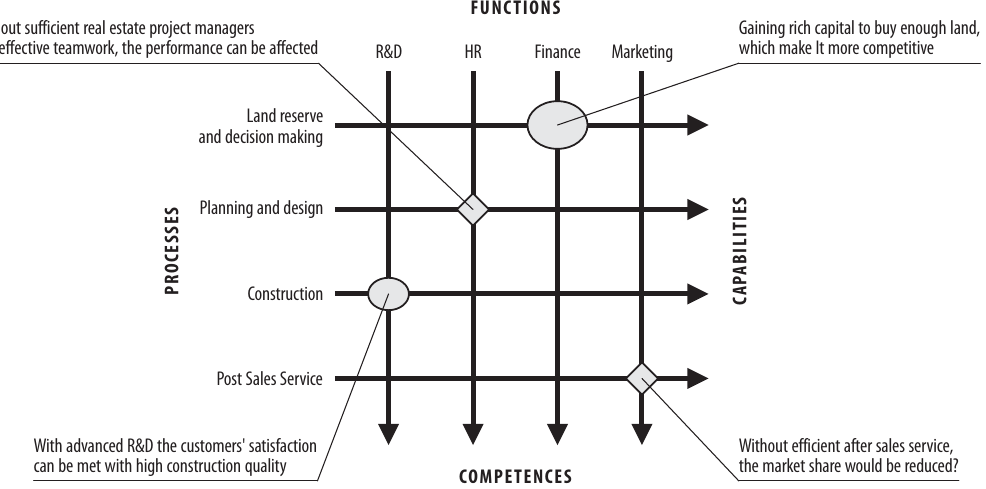
Figure 5. The enterprise model (EM) in application for REEs